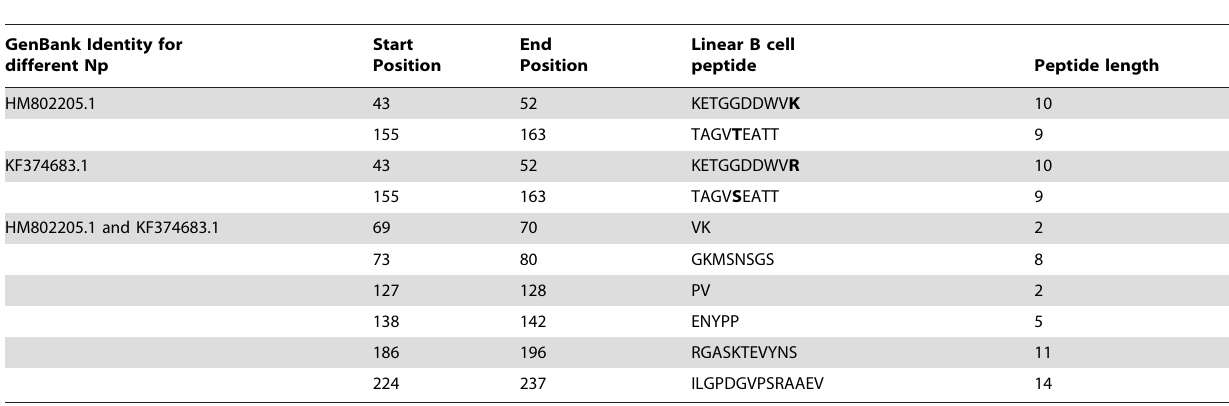
Table 1. Prediction of linear B cell epitopes for nucleocapsid protein from different SFTSV strains.